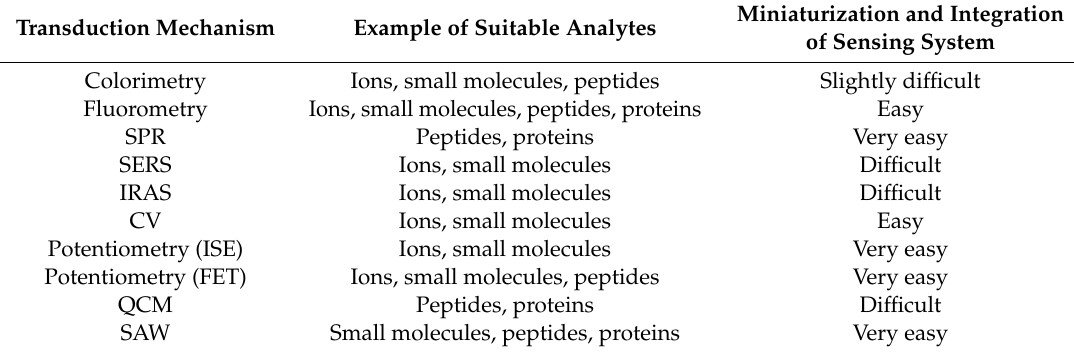
Table 2. “Typical” properties of presented transduction mechanisms in this